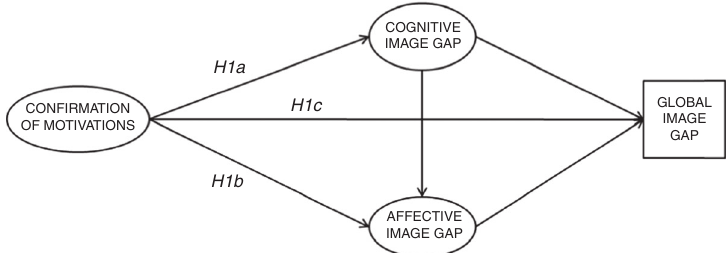
Figure 1. Influence model of the confirmation of motivations in the image